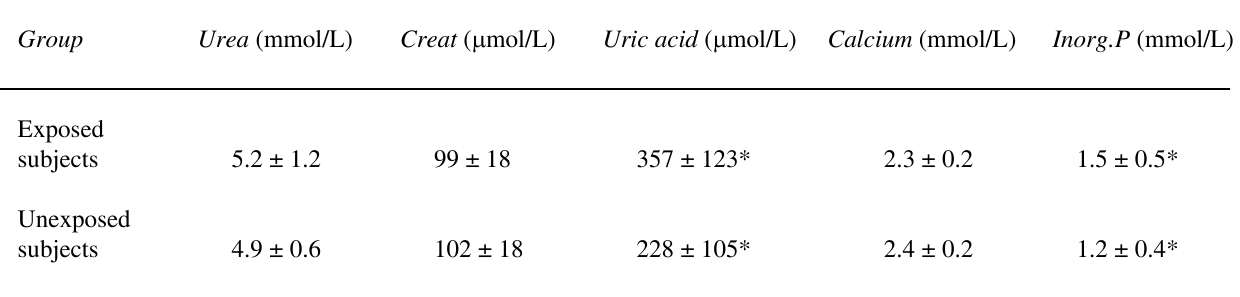
Table 1: Serum urea, creatinine, uric acid, calcium and inorganic phosphorus in human subjects occupationally exposed to lead and in unexposed subjects.